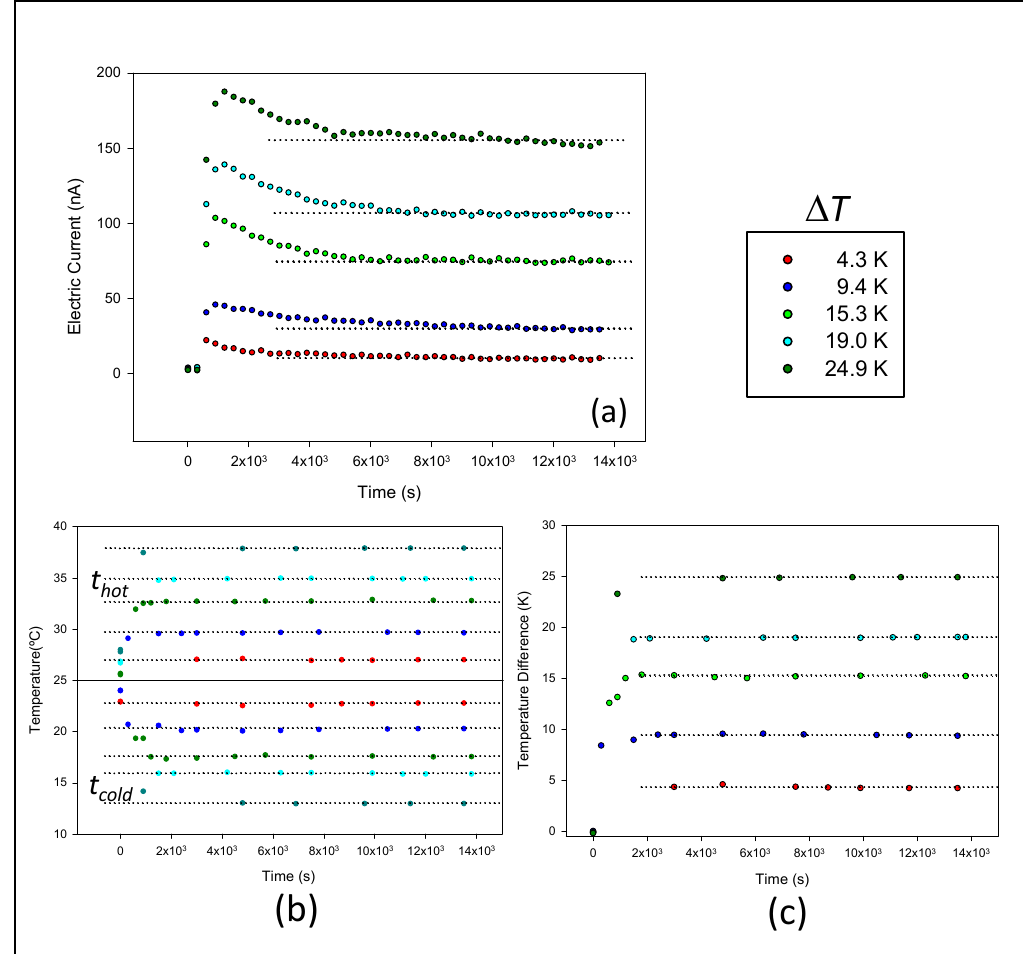
Figure 4. Short-circuit current ( a ), hot and cold temperatures ( b ), and temperature difference ∆ T ( c ) as a function of time. The data correspond to membrane CR61, with NaCl 10 − 4 M, natural convection and a mean temperature of 25 °C.